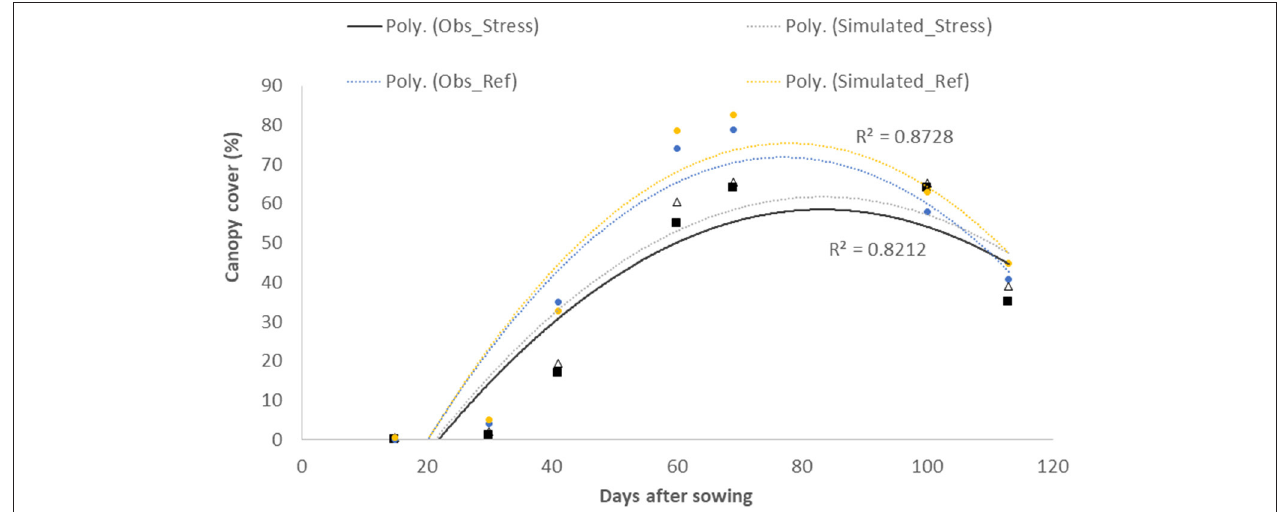
FIGURE 4 | Simulated and observed potato canopy cover progression under a non-stressed fully irrigated and fertilized reference fields (RF) and non-fertilized but fully irrigated calibration fields (stressed calibration field) during 2010 at Barneb 2 Irrigation Scheme in Northeastern Ethiopia. The markers indicate the dates when canopy cover was measured for both the reference fields (Ref) which were fully fertilized with optimum irrigation and stressed fields (stress) which were optimally irrigated but not fertilized. The trend lines indicate the polynomial lines that best fit canopy development with developmental stages.